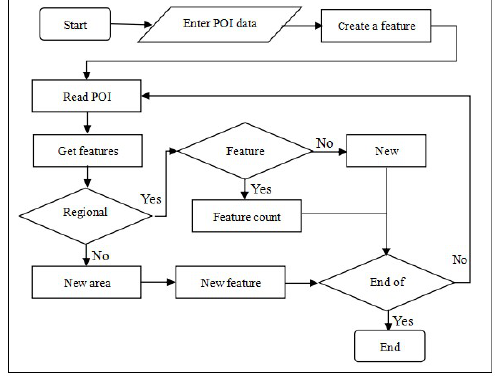
Figure 3 Business feature extraction process